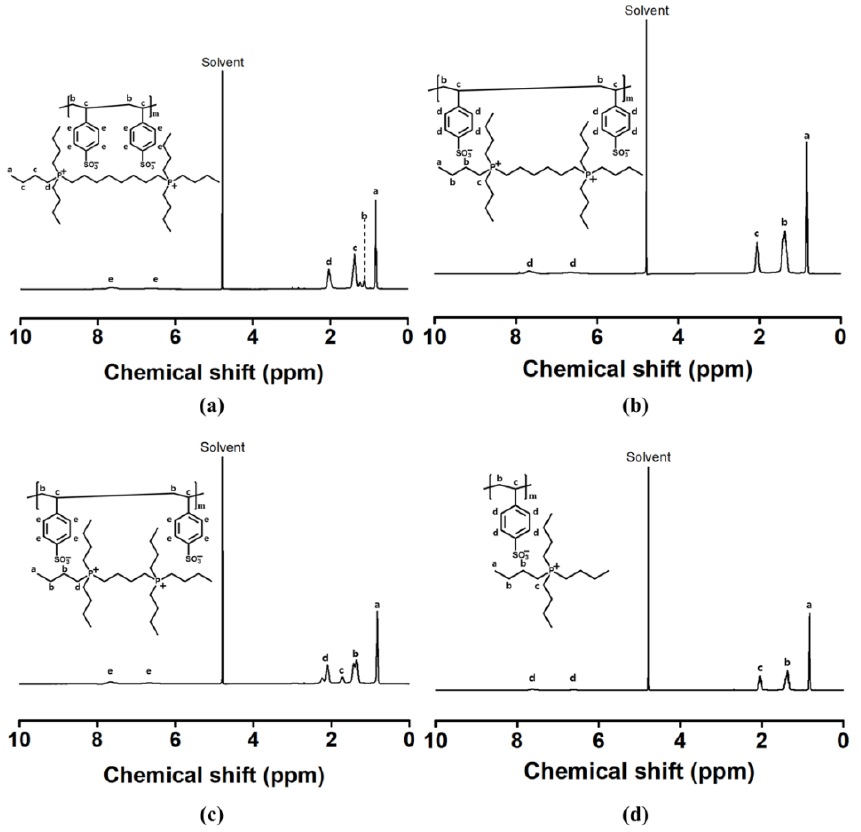
Figure 3. Proton nuclear magnetic resonance ( 1 H-NMR) spectra: ( a ) polymer PSSBP8, ( b ) PSSBP6, ( c ) PSSBP4, and ( d )